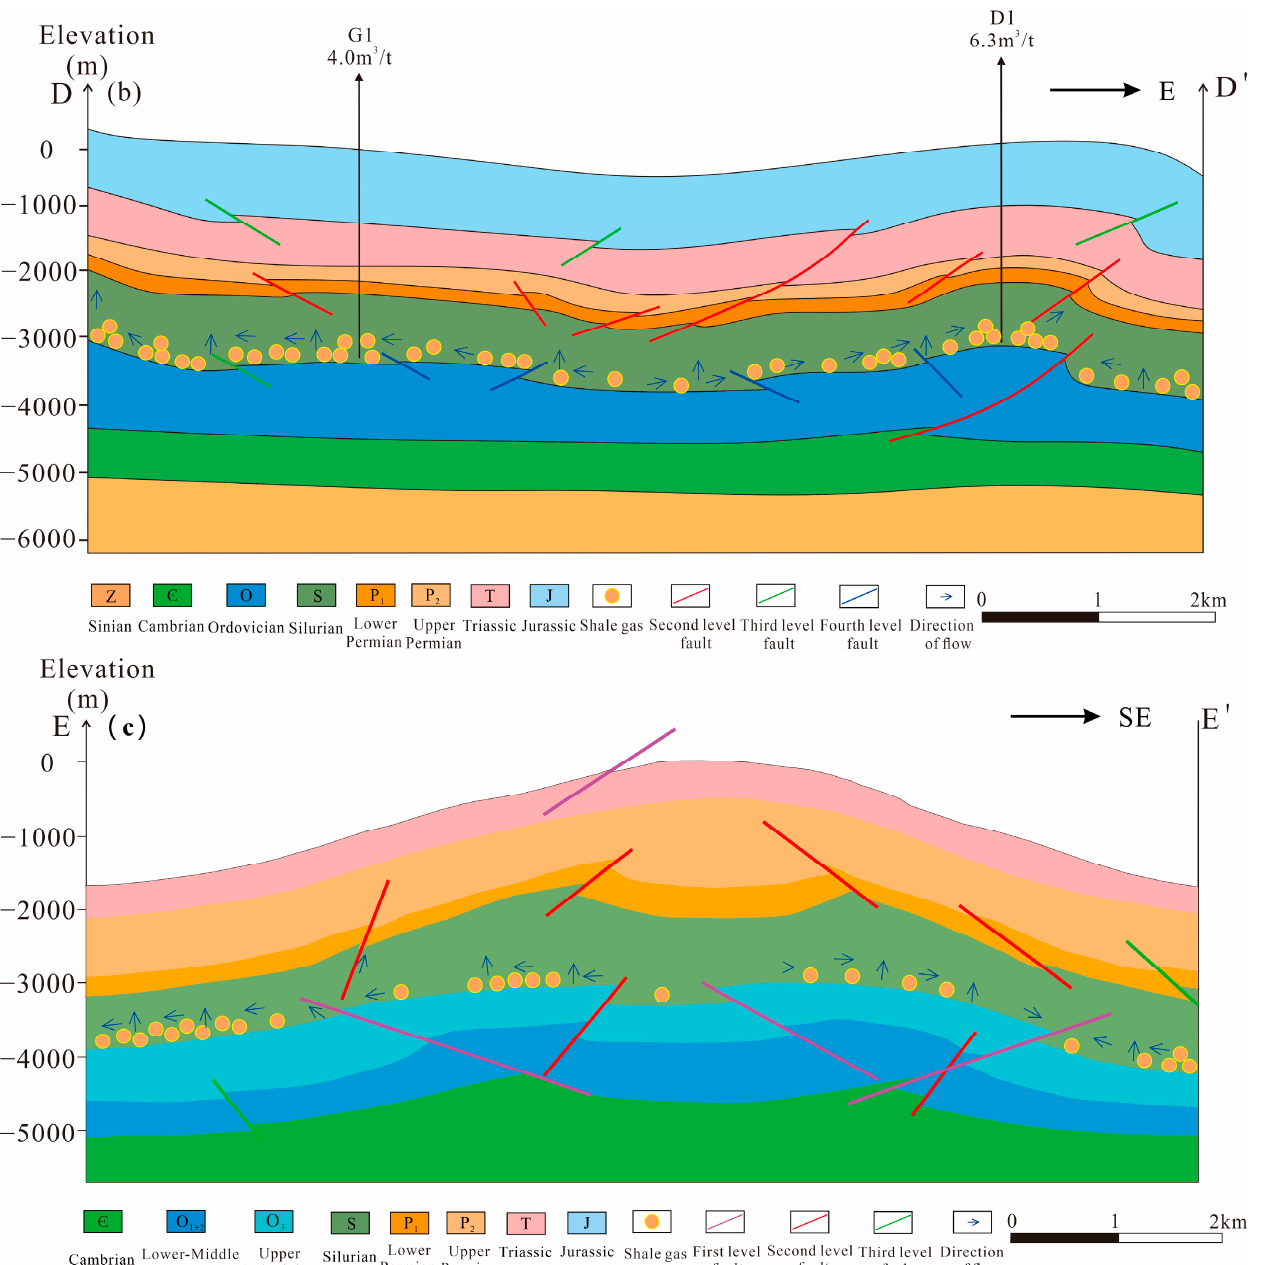
Figure 15. The shale gas enrichment model. The section position is shown in Figure 1C–C ′ , D–D ′ , and E–E ′ . ( a ) Fuji syncline enrichment model; ( b ) Desheng syncline enrichment model; ( c ) Gufo Shan anticline enrichment model.